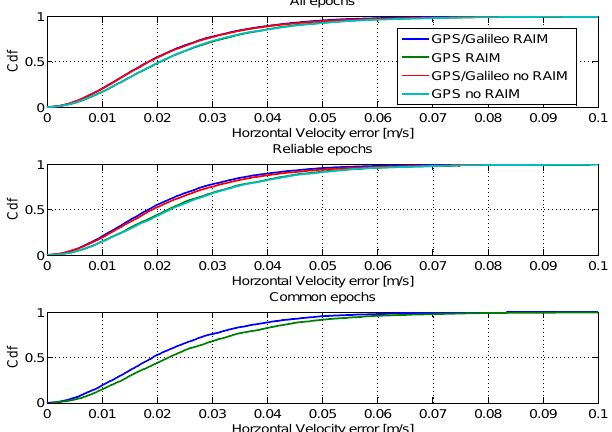
Figure 19. CDFs of the horizontal velocity errors. Upper box: CDFs computed using all available epochs; central box: CDFs computed using only reliable epochs; lower box: CDFs computed using only reliable common